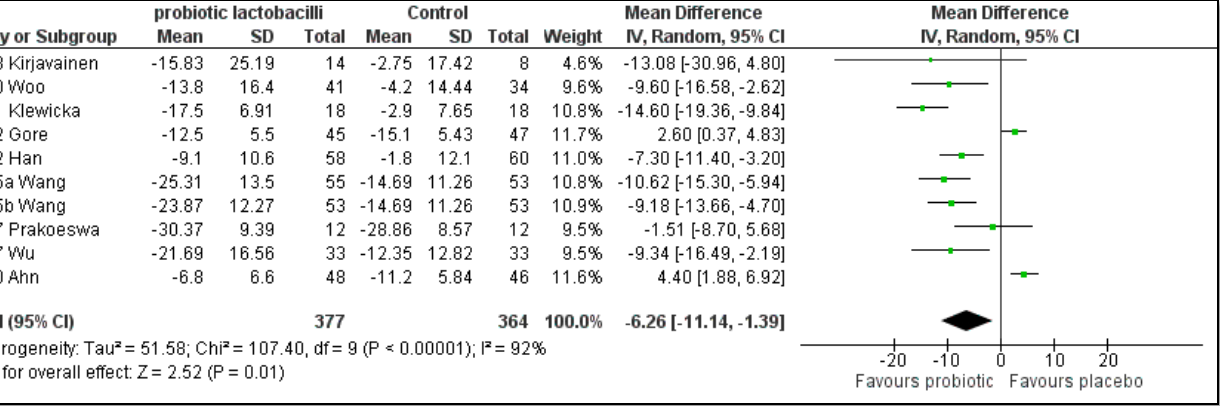
lactobacilli compared to placebo on the SCORAD index change in children with AD [41,44,46,54].